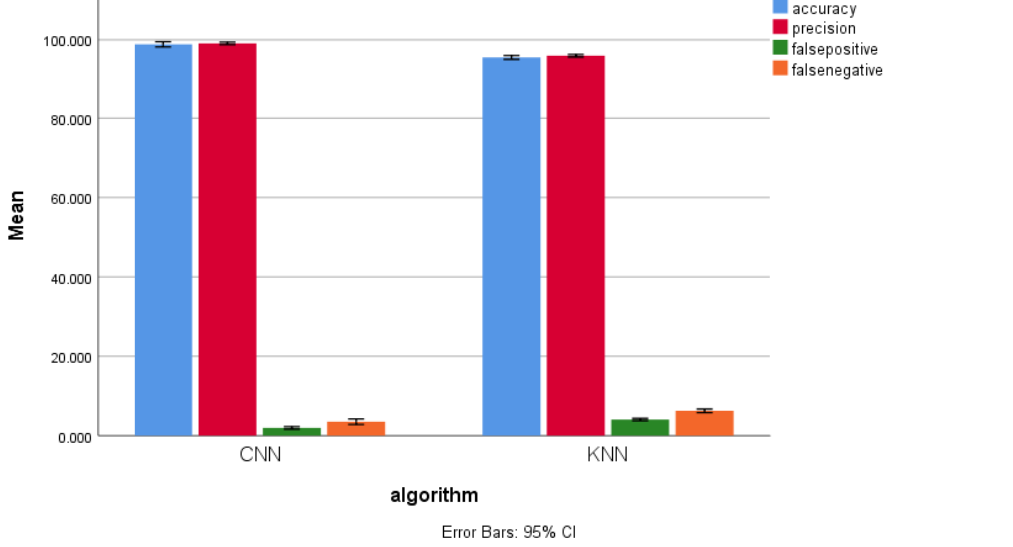
Figure 8. Mean accuracy, mean precision, mean false positive, and mean false negative of CNN and KNN algorithms ’ performance measure with ± 1 standard deviation.